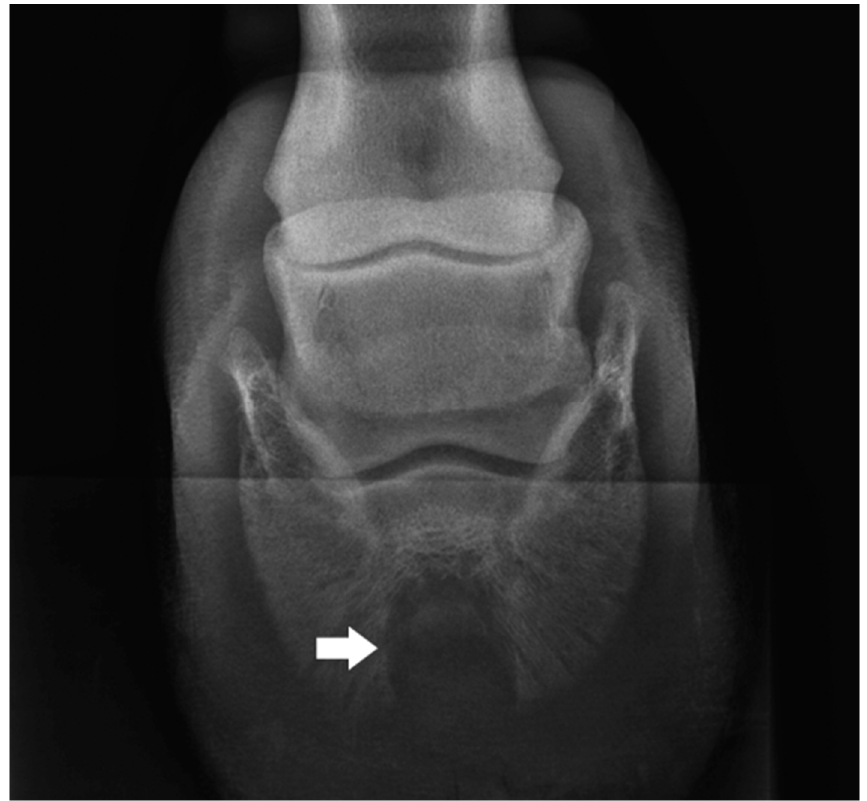
Figure 3. Dorsoproximal ‐ palmarodistal oblique projection with the toe pointing downwards on an Oxspring block, revealing well ‐ defined loss of coffin bone density caused by pressure necrosis from the mass (arrow).